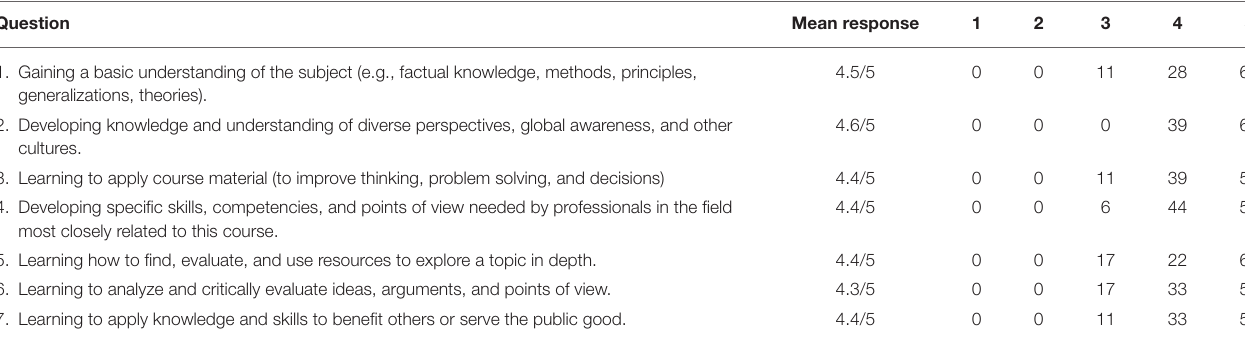
TABLE 2 | Students 2018 assessment of progress on learning outcomes.